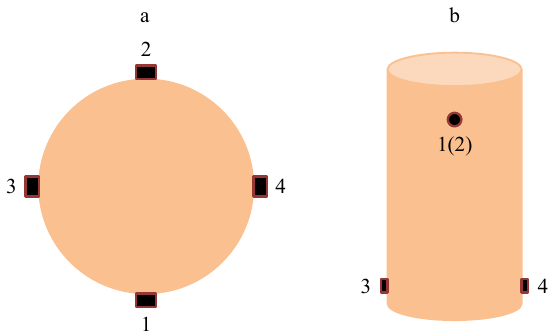
Figure 2. 1,2,3,4 are positions of AE sensors with respect to the rock salt specimens: ( a ) top view and ( b ) side view.